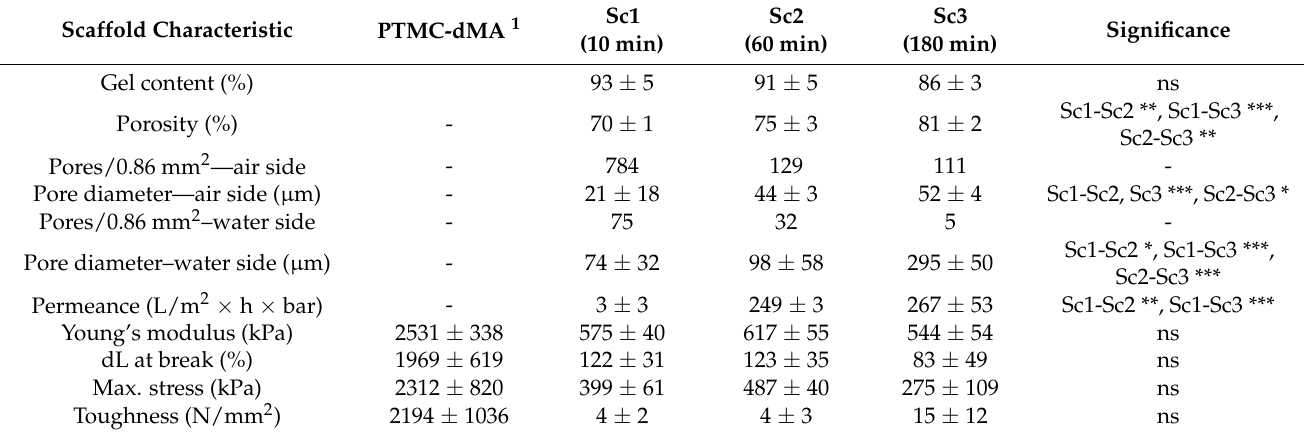
Table 2. Characteristics of PTMC-dMA scaffolds. These scaffolds are prepared at a 25% w / w concentration on ultrapure water at RT. All numbers represent the mean ± SD; ns: p > 0.05, * p ≤